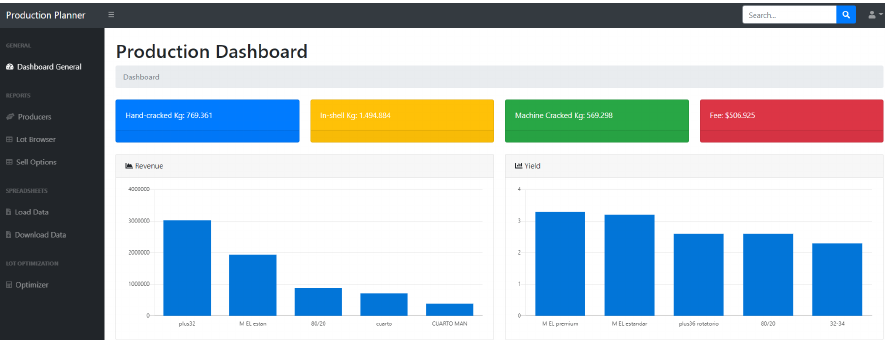
Figure 7. General